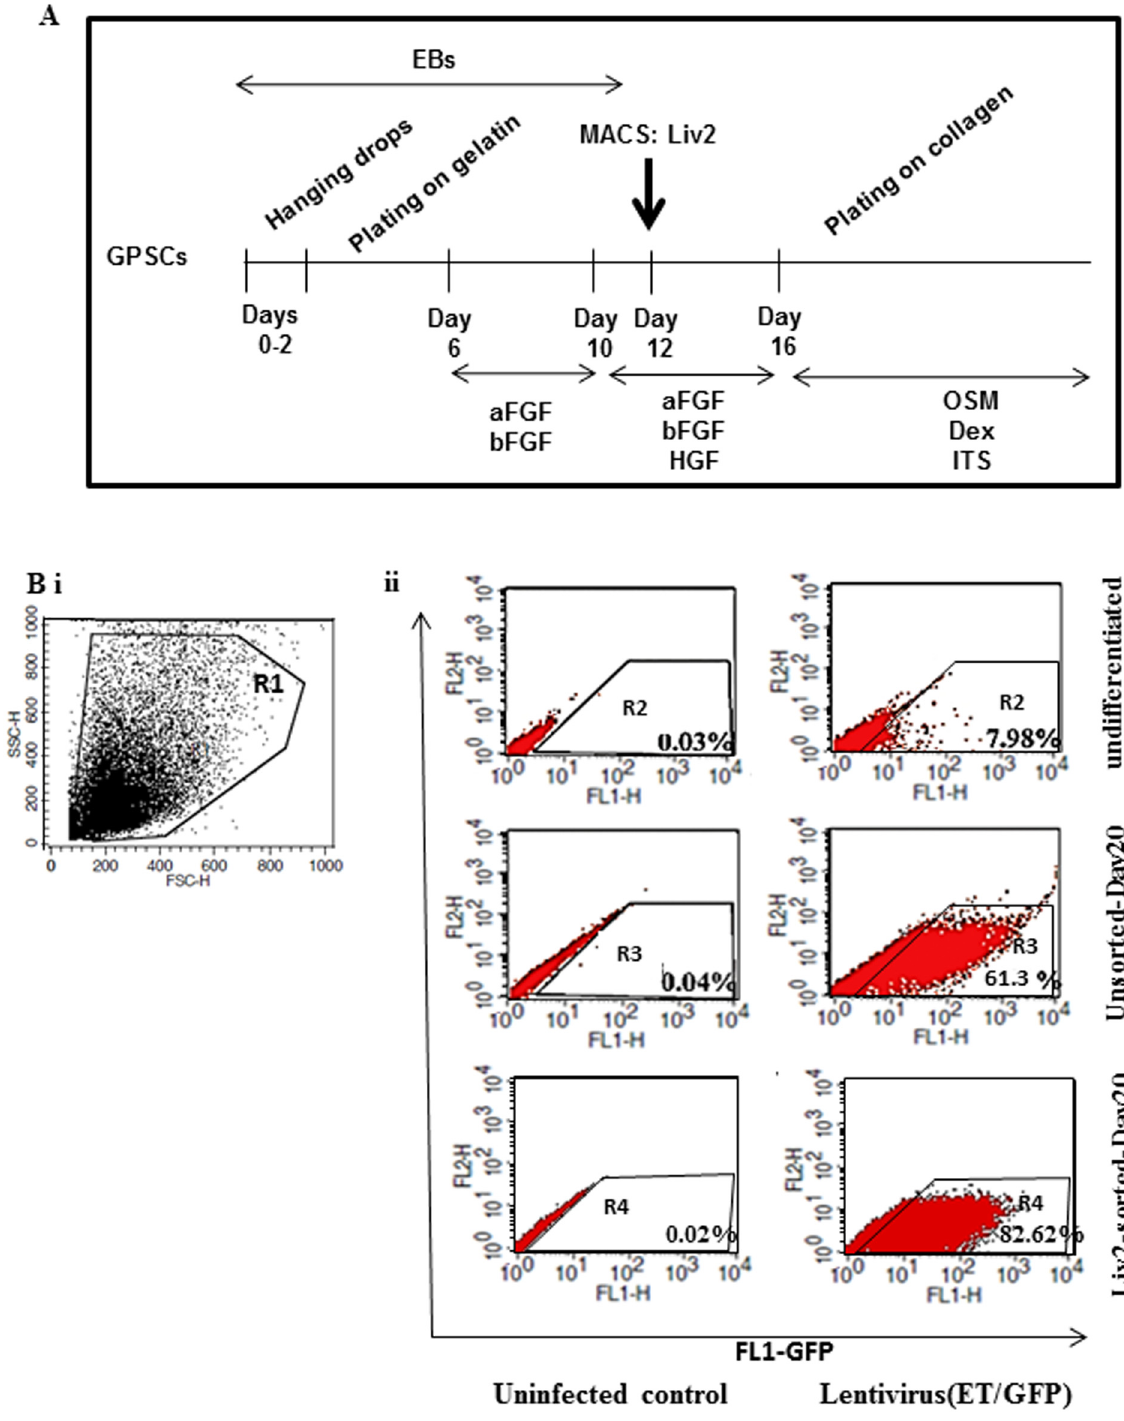
Fig 1. Liv2-positive cell sorting from GPSC-derived EBs. A. Procedure for MACS sorting of Liv2-positive cells and hepatocyte differentiation in vitro . Liv2-positive cells were sorted from GPSC-derived 13 days old EBs and further differentiated into hepatocytes in vitro . B. A forward-and-side-scatter plot with gating on live cells (R1) is shown (i). Unsorted GPSCs under basal conditions (undifferentiated), and after 20 days of differentiation (Unsorted) as well as Liv2-sorted GPSC derived hepatocytes (Liv2-sorted) at day 20 of induced differentiation (ii) were infected with pCCL-ET.GFP virus which expresses GFP specifically in hepatocytes and analysed by flow cytometry. GFP fluorescence (FL1) is shown for negative controls (uninfected control) and for the infected samples (Lentivirus (ET/GFP)). Regions 2, 3, and 4 (R2, R3 and R4) were designed to measure GFP fluorescence in infected cells versus non-infected controls. doi:10.1371/journal.pone.0136762.g001 PLOS ONE | DOI:10.1371/journal.pone.0136762 August 31,